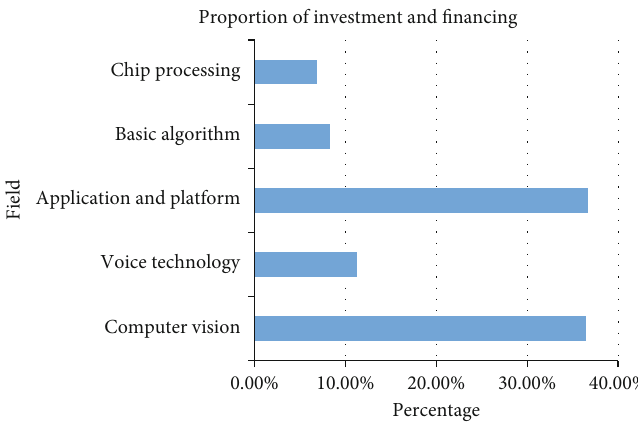
Figure 3: The investment and fi nancing segments of the arti fi cial intelligence industry in 2019.